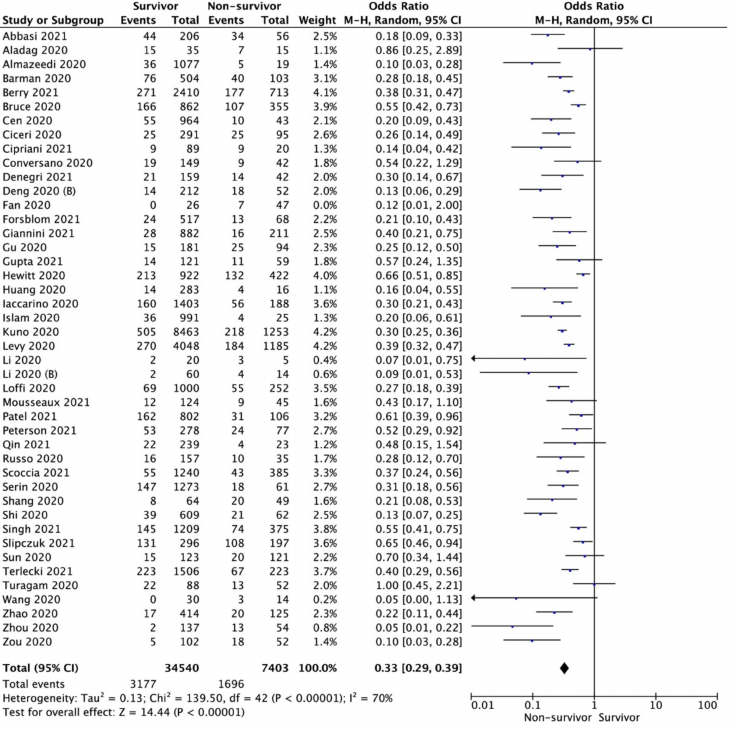
Figure 2. Forest plot of coronary artery disease occurrence in survivor vs. non-survivor groups. The center of each square represents the weighted odds ratios for individual trials, as the corresponding horizontal line stands for a 95% confidence interval. The diamonds represent pooled